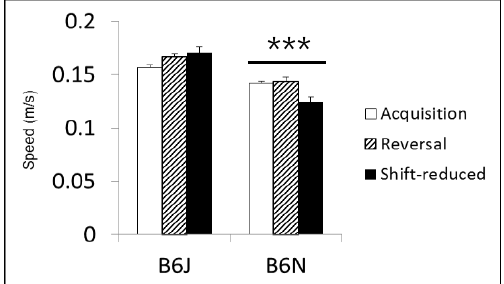
Figure 7. Morris water maze swim speed: females. B6J females swam significantly faster than B6N females in all three hidden platform phases. *** p < 0.001. Data are the least square means ±